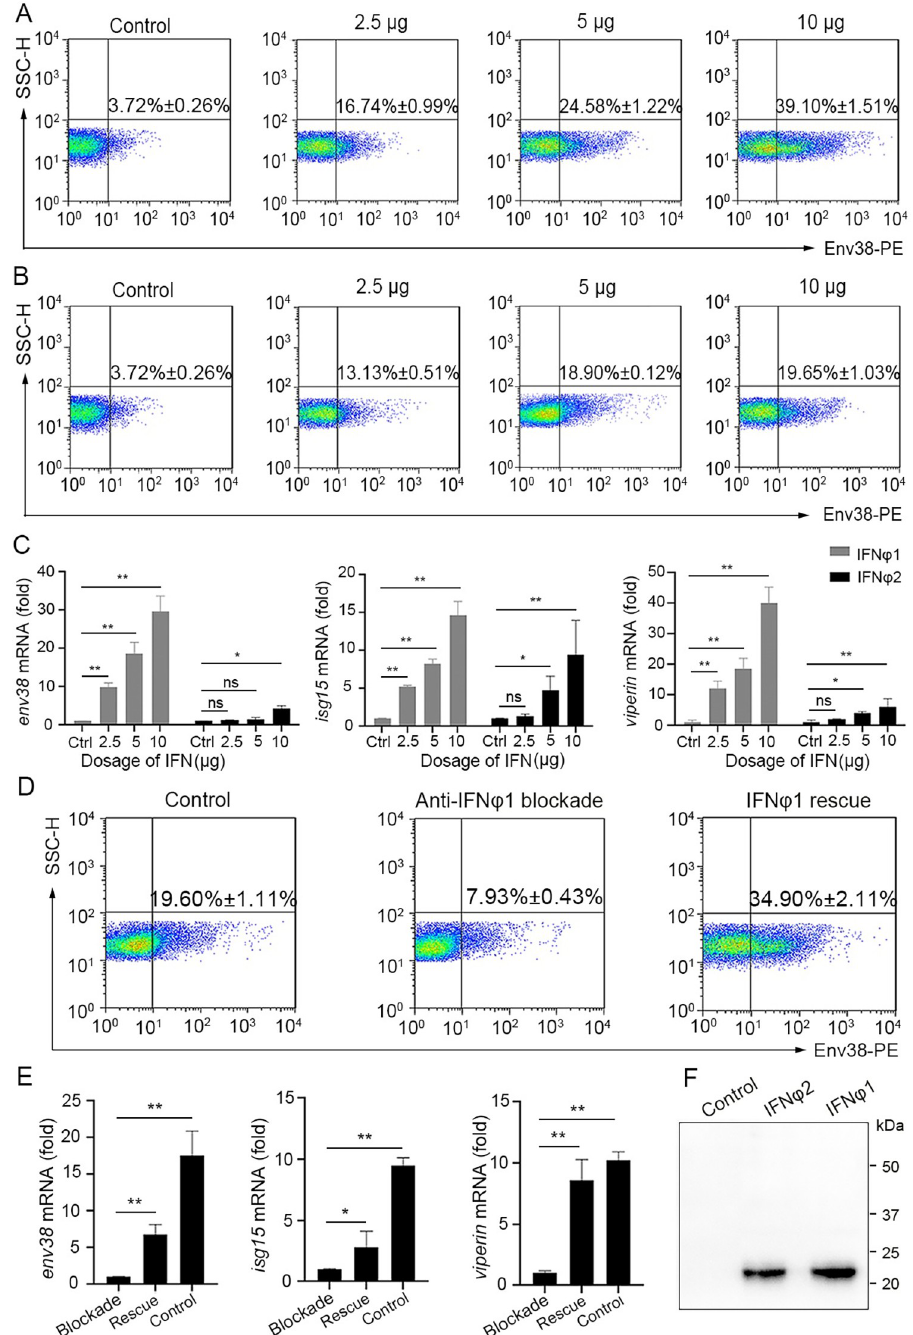
Fig 12. Examination on the stimulatory role of zebrafish IFN φ 1/IFN φ 2in Env38 production. (A-C) Examination on the stimulatory role of zebrafish IFN φ 1 and IFN φ 2 in Env38 expression by in vivo administering recombinant IFN φ 1 and IFN φ 2 proteins. The stimulatory effect was examined by the increased percentage of Env38 + cells and the upregulated transcriptional expression of env38 , isg15 and viperin genes in leukocytes from spleen, head kidney and peripheral blood of zebrafish i.p. injected with proportional dosage (2.5 μ g, 5 μ g and 10 μ g) of the IFN φ 1 (A) or IFN φ 2 (B) through FCM analysis (A and B) and RT-qPCR (C), respectively. Zebrafish i.p. injected with mock PBS was used as control. (D and E) Examination on the stimulatory role of zebrafish IFN φ 1 in Env38 expression by in vivo neutralization and rescue assays via administering mouse anti-IFN φ 1 Ab (10 μ g/fish) and recombinant IFN φ 1 (10 μ g/ fish) back into the IFN φ 1-neutralized zebrafish. The stimulatory effect was examined by the percentage of Env38 + cells